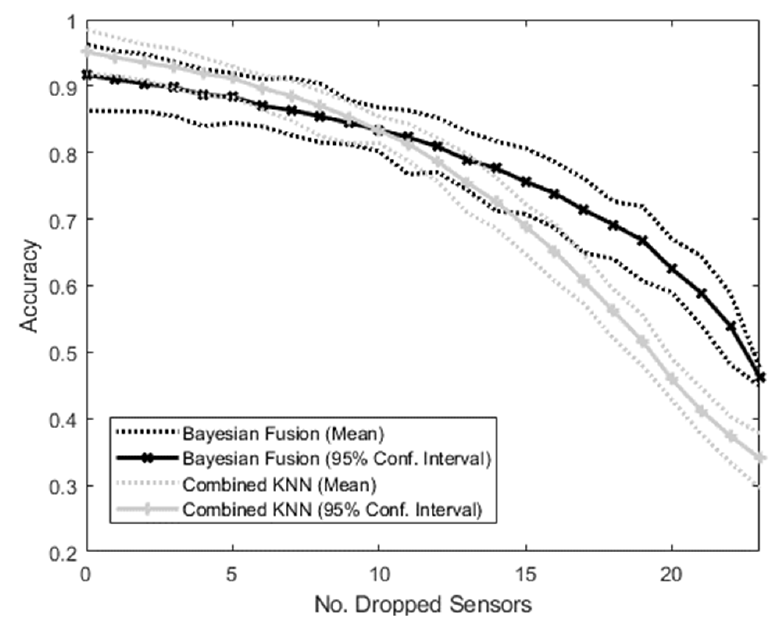
Figure 7. Graph showing the accuracy of the intent-classification system with increasing number of sensors dropping out. The Bayesian Fusion method (treating each sensor separately and then combining them) and the combined method (putting all sensor information into a single KNN classifier) are shown.